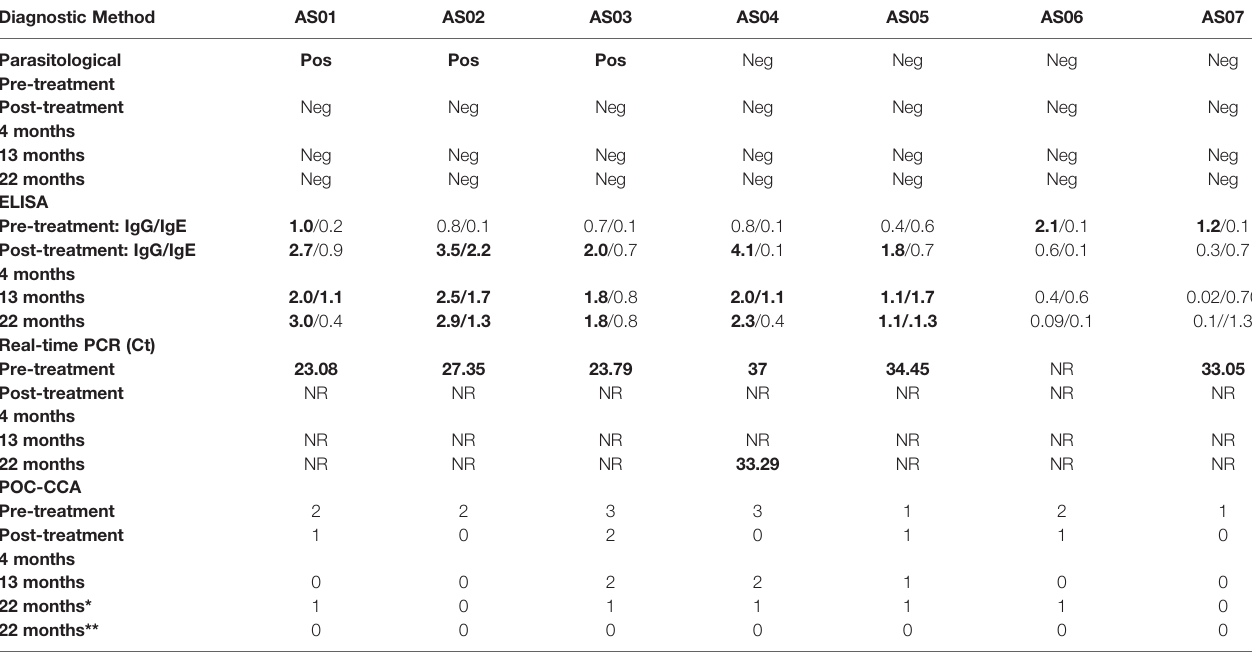
TABLE 2 | Diagnosis pre-treatment and response to treatment